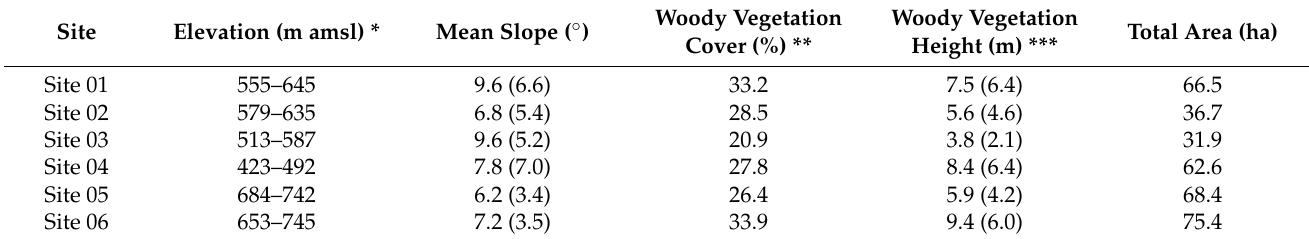
Table 1. Detailed selected environmental parameters of individual study sites situated in the Doupovske hory military training area (derived from custom-ordered high density ALS